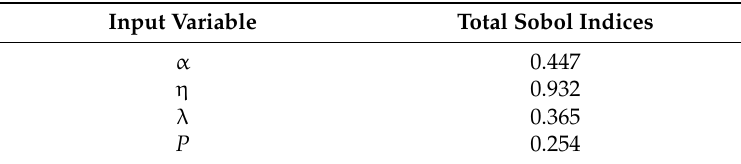
Table 6. Total Sobol indices of the inputs contributing to the 90th percentile of the exposure in the